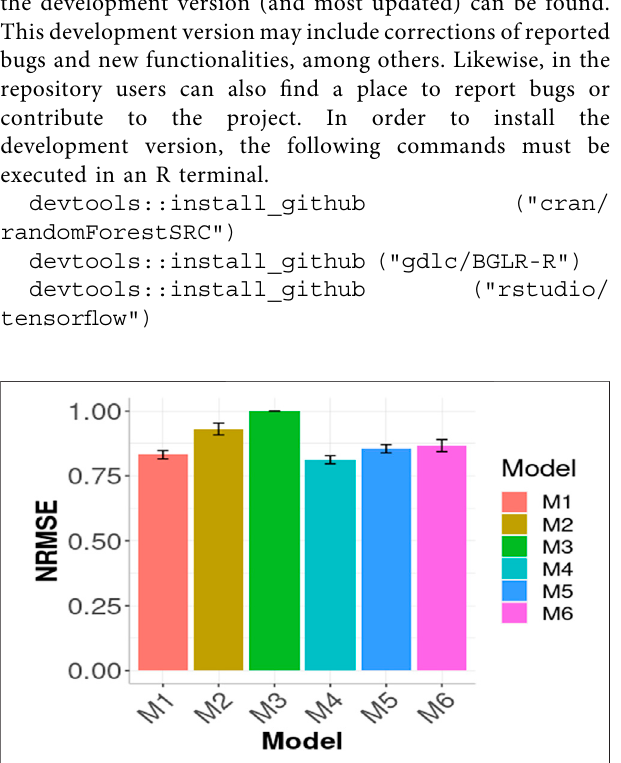
FIGURE 1 | Prediction performance in terms of Mean Squared Error of the six models (M1, M2, M3, M4, M5, M6) across environments (Global) in the wheat data. M1 denotes the generalized boosted machine model, M2 denotes the generalized linear model, M3 denotes the support vector machine model, M4 denotes the random forest model, M5 denotes the Bayesianregressionmodel and M6denotes thedeep neural networks model.